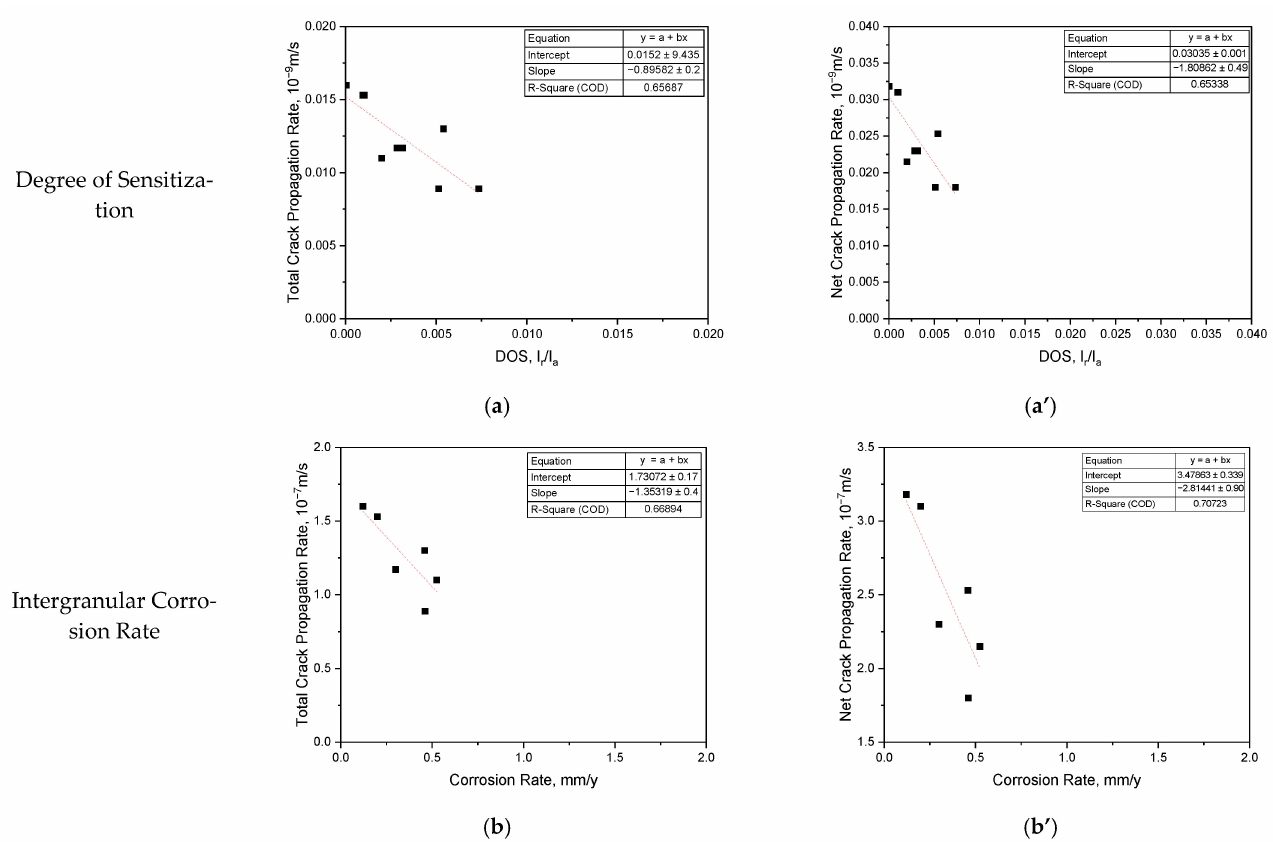
Figure 13. Relationship between crack propagation rate and intergranular corrosion: ( a , b ) total crack propagation, ( a’ , b’ ) net crack propagation